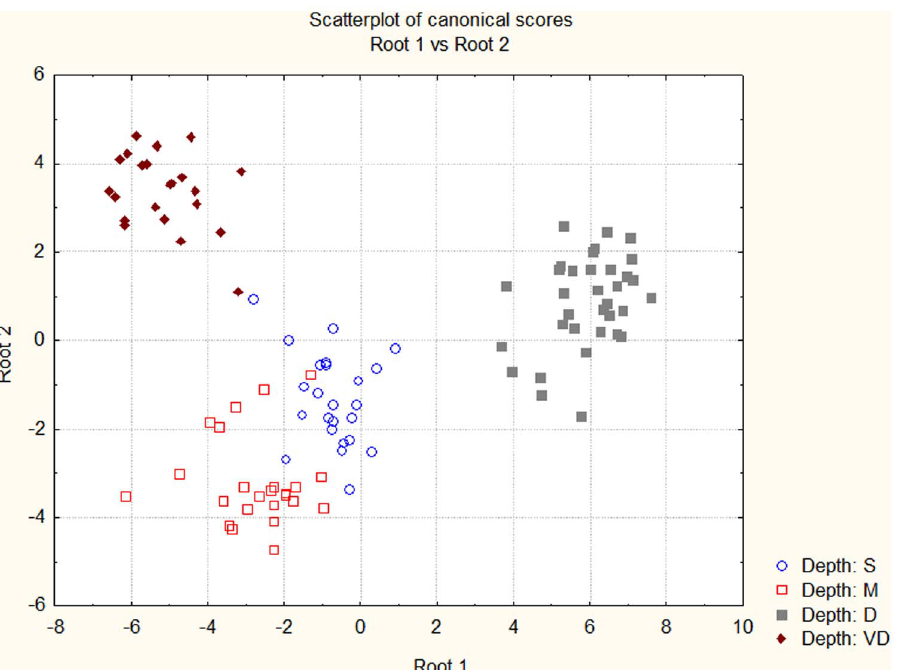
Figure 2. Plot of standardized coefficients for canonical variables based upon discriminant function analysis of samples classified only by collection depth. Shallow (3–10 m) - circles, Medium depth (15–25 m) – open squares, Deep (30–50 m) – closed squares, and Very Deep (60–90) – diamonds